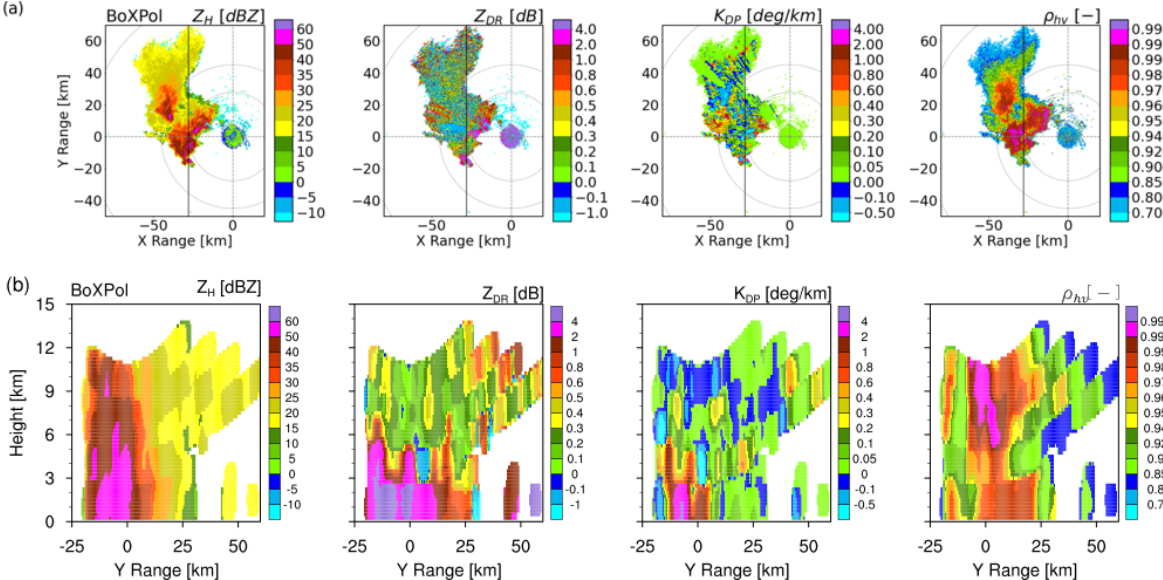
Figure 5. (a) PPI plots of horizontal reflectivity, differential reflectivity, specific differential phase and cross-correlation coefficient at 8.2 ◦ elevation measured by BoXPol on 5 July 2015 at 15:30UTC. The dotted grey circles represent slant ranges for the chosen elevation angle, associated with heights of 1km (lower levels), 4.5km (melting layer) and 7km (upper levels). (b) Cross section of the same polarimetric variables from the gridded data. The vertical solid black line along the y axis in panel (a) indicates the location of cross-section